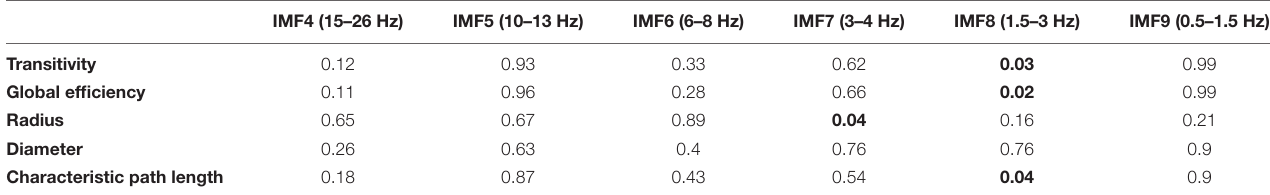
TABLE 3 | P -values of the correlation analysis of the graph-theoretical